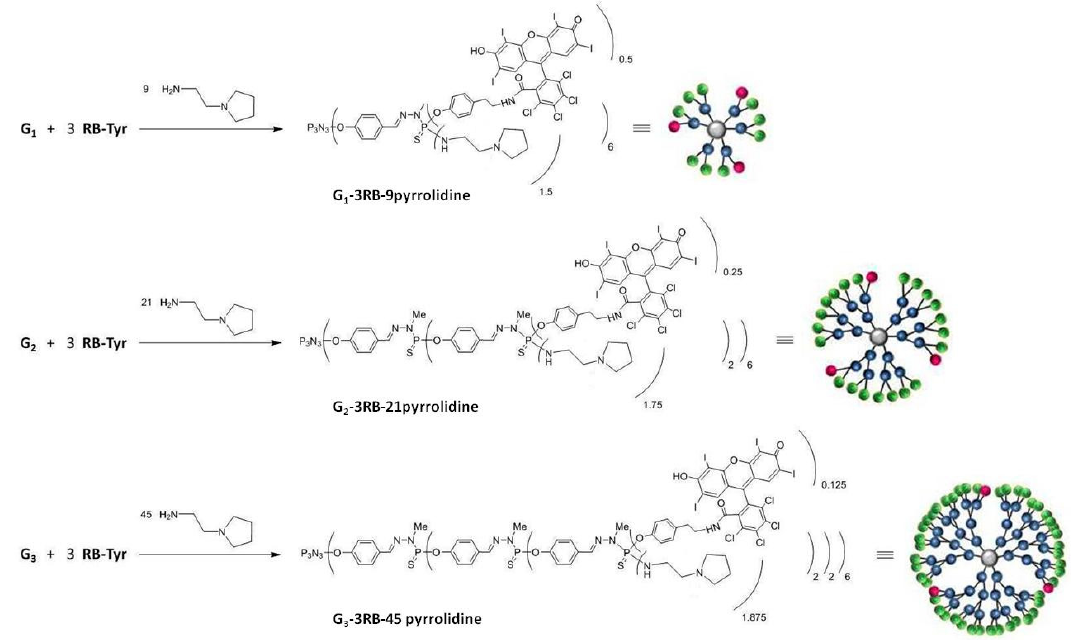
Figure 13. The scheme of the synthesis of the G1–, 2–, 3–RB–pyrrolidine conjugates.